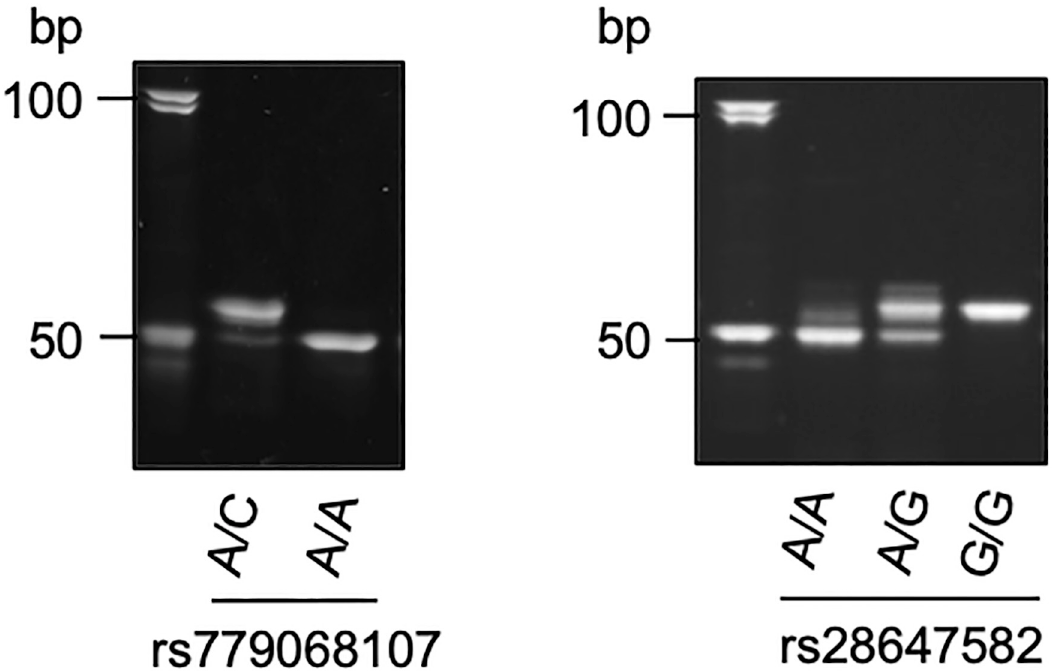
Fig 3. APLP method to detect two substitutions of rs779068107 (left) and rs28647582 (right). Amplified products were electrophoresed in 12% polyacrylamide gel, followed by ethidium bromide staining. Molecular size markers are in the left lane.